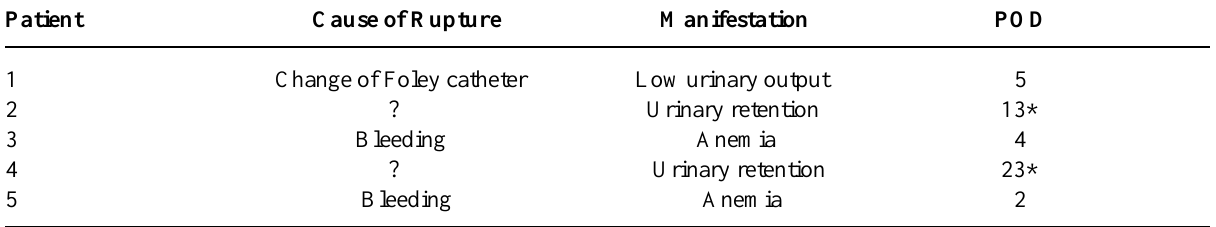
Table 1 - Characteristics of rupture of vesicourethral anastomosis.